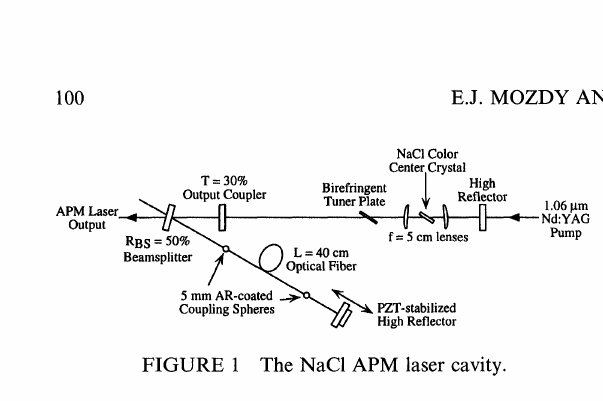
FIGURE The NaC1 APM laser cavity. is exactly matched in length to the main cavity.